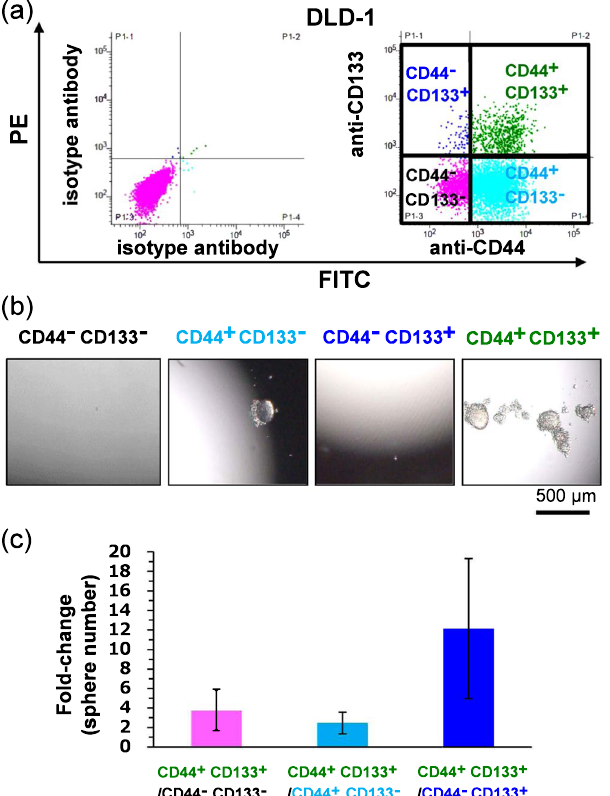
Figure 1. Formation of stem cell spheres after seeding sorted CD44 + CD133 + , CD44 − CD133 − , CD44 − CD133 + , and CD44 + CD133 − cells of the colorectal cancer (CRC) DLD-1 cell line. ( a ) Left column shows isotype control and right column shows anti-CD44-FITC and anti-CD133-PE antibody double-staining of DLD-1 cells. The quadrants comprising each population are defined as CD44 − CD133 + , CD44 + CD133 + , CD44 − CD133 − , and CD44 + CD133 − , respectively. ( b ) Representative sphere images of CD44 − CD133 − cells, CD44 − CD133 + cells, CD44 + D133 − cells, and CD44 + CD133 + cells are shown from the left to right column, respectively. ( c ) Sphere numbers determined for CD44 − CD133 − , CD44 − CD133 + , CD44 + D133 − , and CD44 + CD133 + DLD-1 cells. Data points represent means ± SD (n =